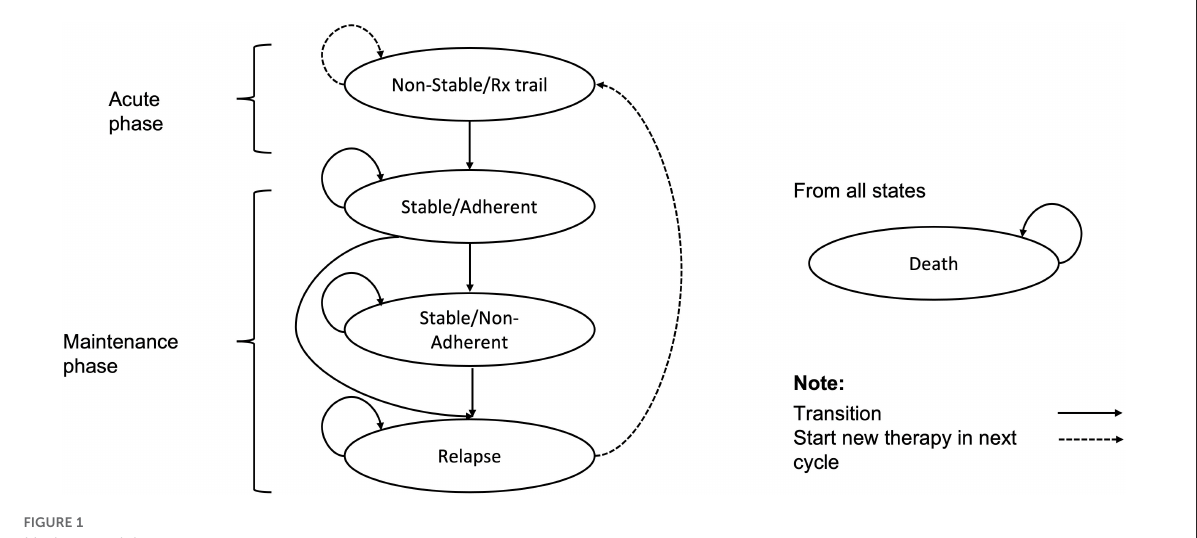
FIGURE1 Markov model